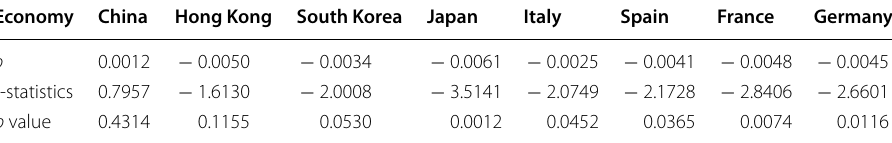
Table 2 Results of the OLS regression model (2) Economy